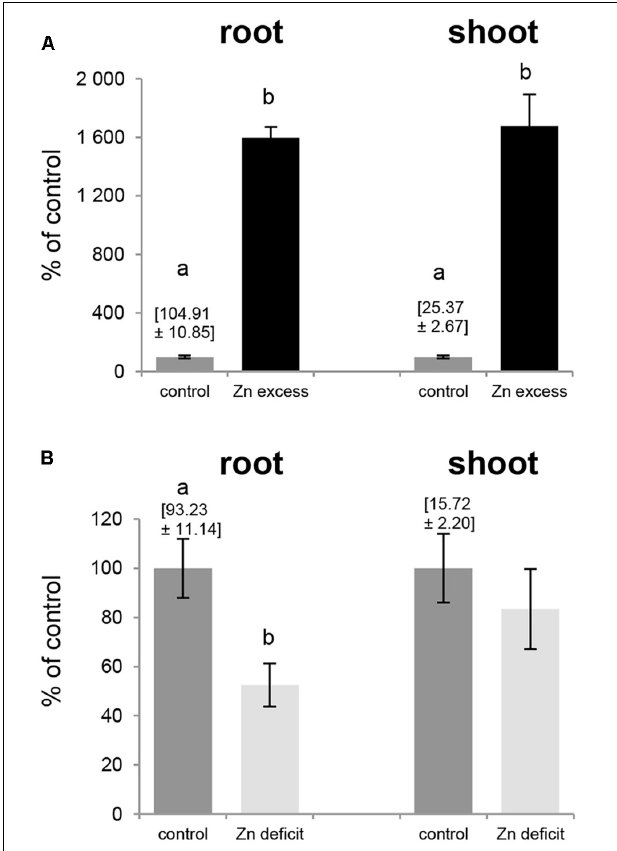
FIGURE 7 | Zinc concentration in tobacco plants. Plants were grown in the quarter-strength Knop’s medium (control) and then transferred to the control medium supplemented with 50 µ M Zn for 1 day (Zn excess), or to the medium without Zn for 4 days (Zn deficit). Results are demonstrated as percent of the control values: Zn concentration at control conditions equals 100%, and at Zn excess and Zn deficit is shown as multiple of values for the control ones. Zn concentrations [mg/kg dry weight] at control conditions is given above the control bars. (A) Zn excess – 50 µ M Zn; (B) Zn deficit. Values correspond to means ± SD ( n = 10). Significant differences between the control plants and plants exposed to a given Zn concentration (Zn excess or Zn deficit) are marked by different letters – evaluated by Student’s t -test ( P ≤